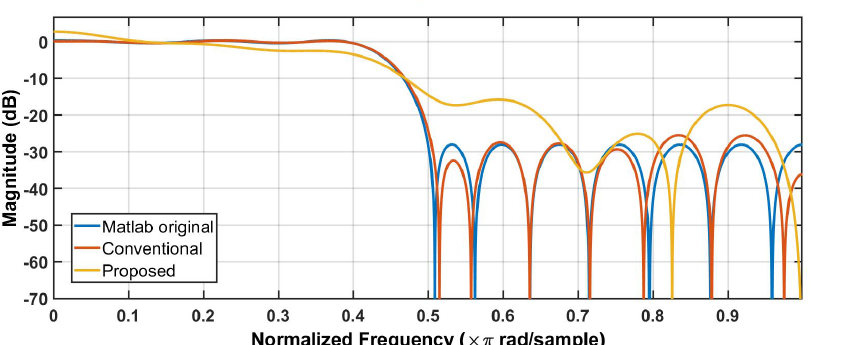
Figure 8. Frequency response of conventional design versus proposed design in the worst case (slow-slow (SS) process corner and 125 ◦ C